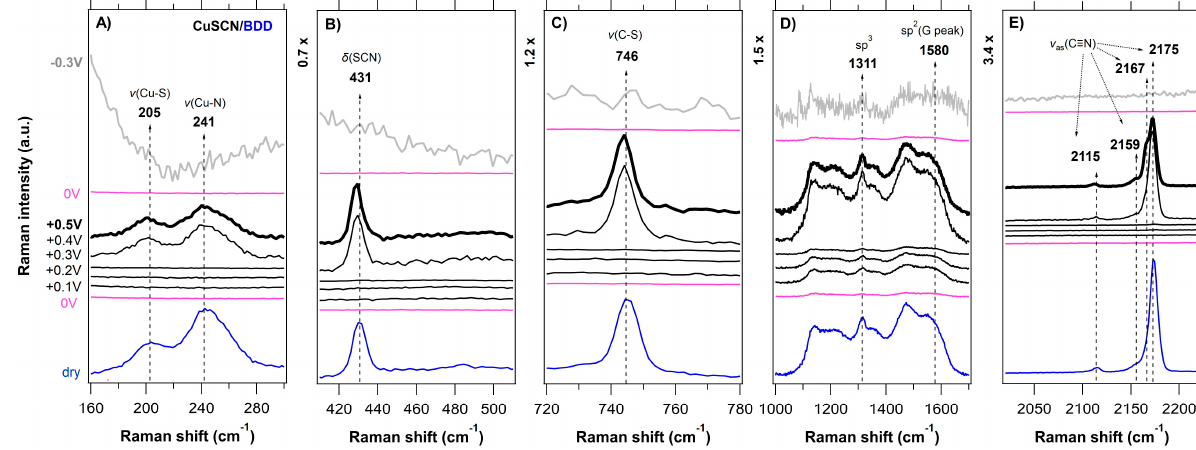
Figure 4. In situ Raman- µ SEC spectra of the CuSCN layer (spectral regions of 160–300, 410–510, 720–780, and 2020–2220 cm –1 in charts ( A – C , E ), respectively) electrodeposited on the BDD substrate (spectral region of 1000–1700 cm –1 in chart ( D ) as a function of the applied potential (vs. Ag/AgCl; shown on the left-side chart) in 6 M LiCl. The measurement sequence was as follows; the first spectrum was acquired at 0 V (bottom pink trace) and the last spectrum was acquired at − 0.3 V (top gray trace). The sequence of positive potentials (from +0.1 V to +0.5 V) is visualized by black traces. The reference (ex situ) Raman spectrum of the dry CuSCN layer on the BDD substrate is shown for comparison (bottom blue trace). Spectra are offset for clarity; the intensity scale is identical for all the charts.